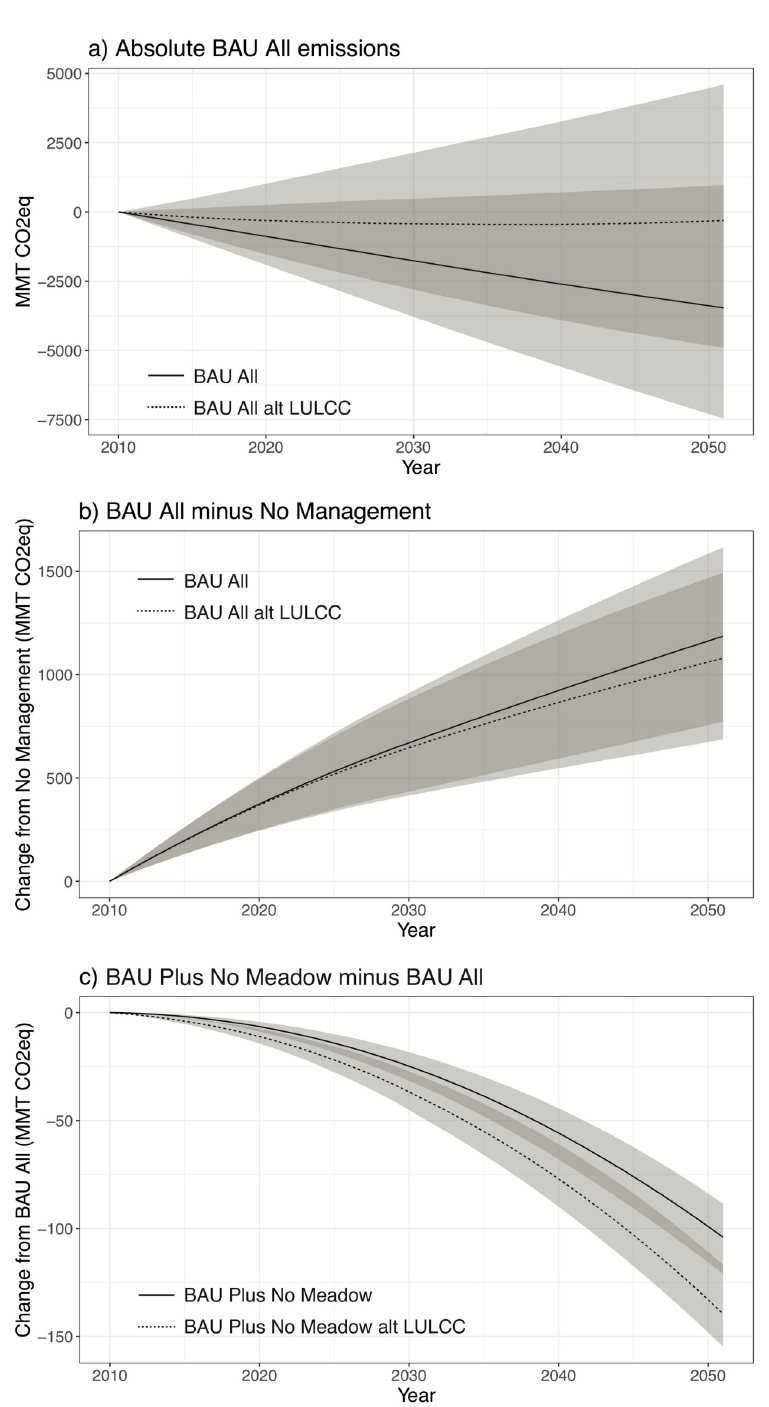
Fig 10. Uncertainty in cumulative BAU management emission estimates. These are based on a) absolute landscape carbon exchange, b) BAU All emissions with respect to no management, and c) benefits of implementing restoration (sans Meadow), soil conservation, and avoided conversion to Urban area (BAU Plus No Meadow) with respect to BAU management (BAU All). The shaded area denotes output ranges due to uncertainties in input carbon densities and fluxes, and the two scenarios distinguish between the default land-use-driven baseline land use/cover change (solid line; LULCC) and the alternative remotely-sensed baseline land use/cover change (dashed line; alt LULCC). See Table 3 for scenario